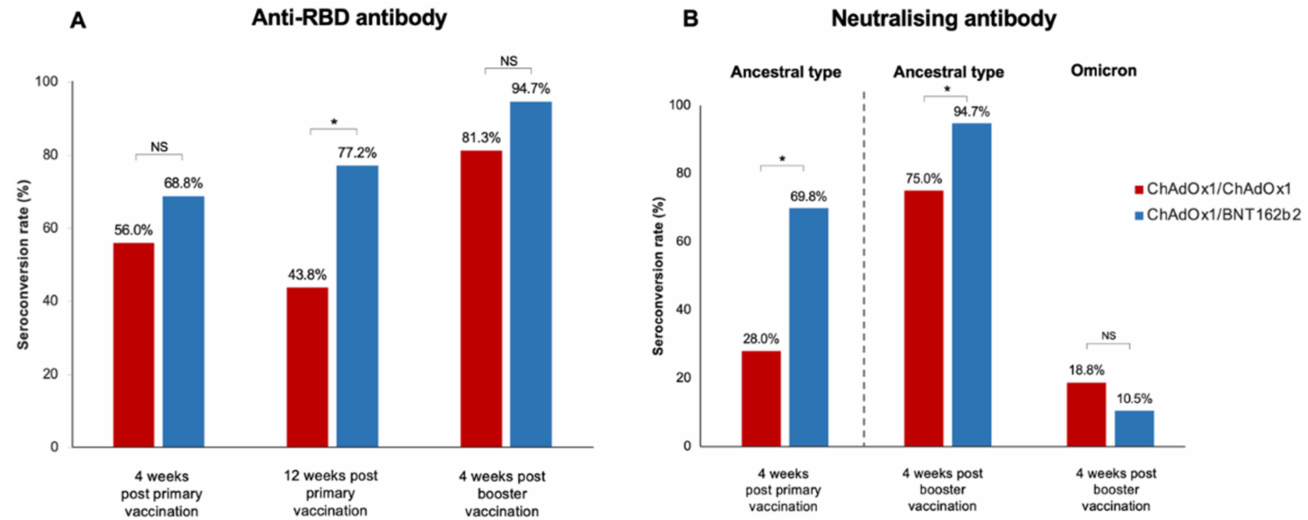
Figure 1. Seroconversion rate after primary vaccination and booster in LT recipients ( A ) Anti-SARS-CoV-2 receptor-binding-protein antibody (anti-RBD), ( B ) Neutralising antibody to the ancestral type and omicron strain after booster vaccination (*, statistically significant; NS, non-statistically